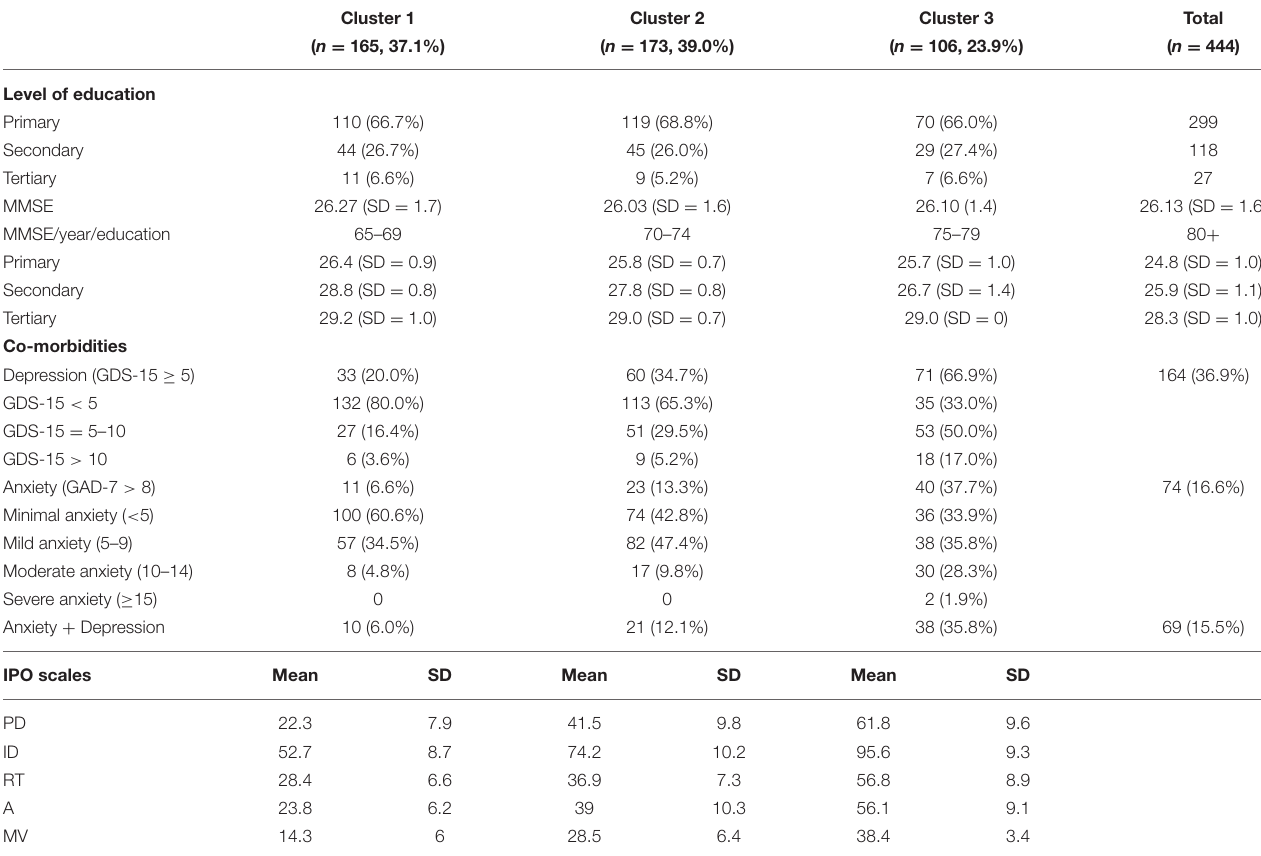
TABLE 1 | Descriptive statistics of the